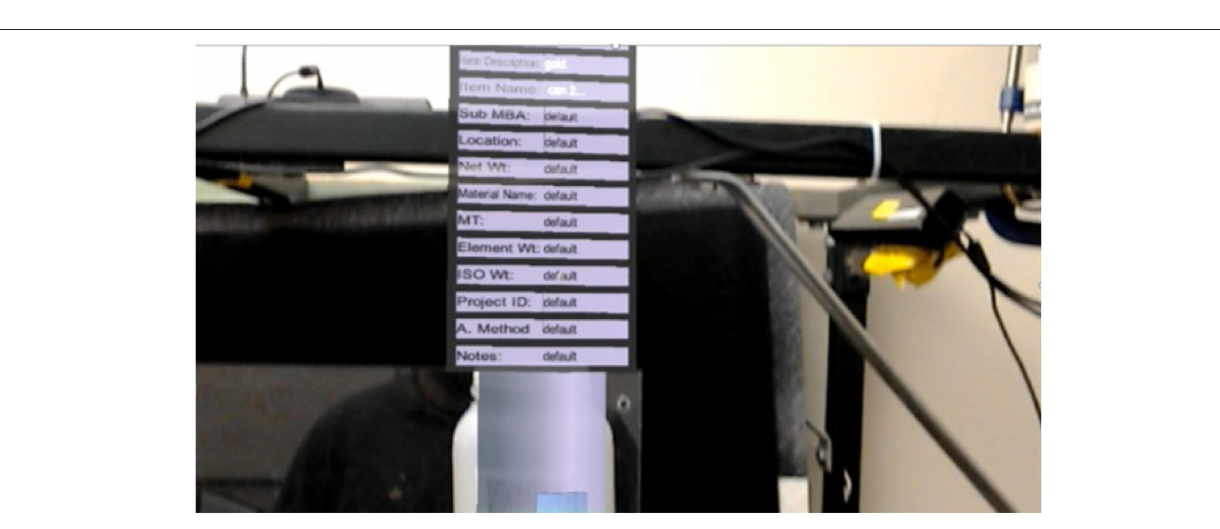
FIGURE 21 | The documentation associated with the canister comes into the operator’s field of